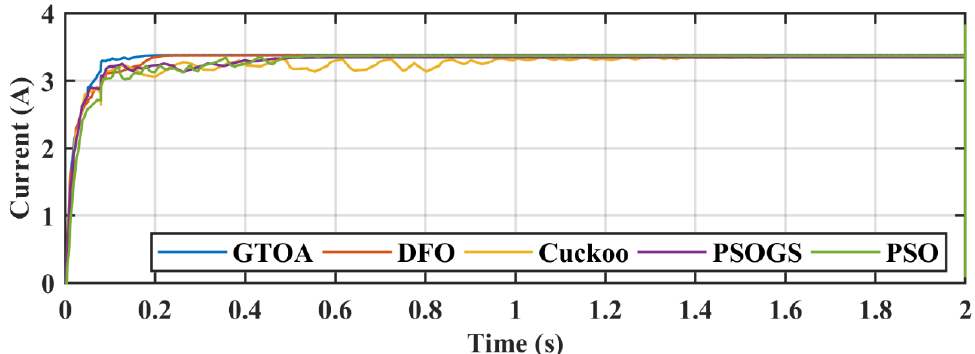
Figure 26. Comparison of current transients of GTOA.